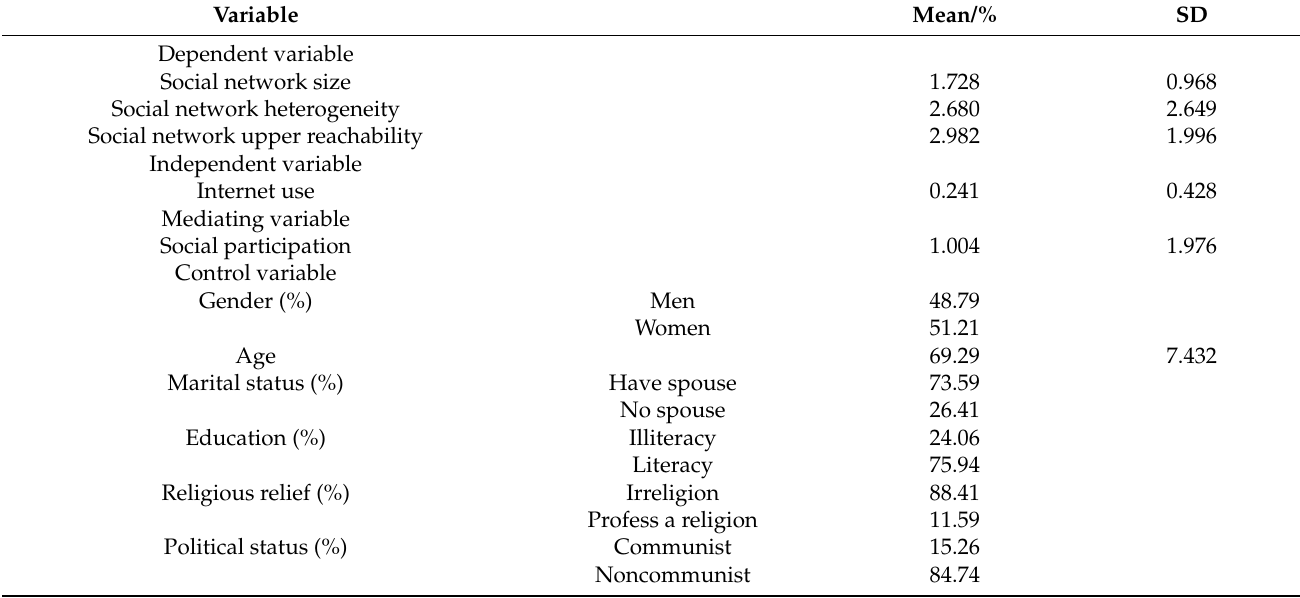
Table 1. Descriptive statistical results of